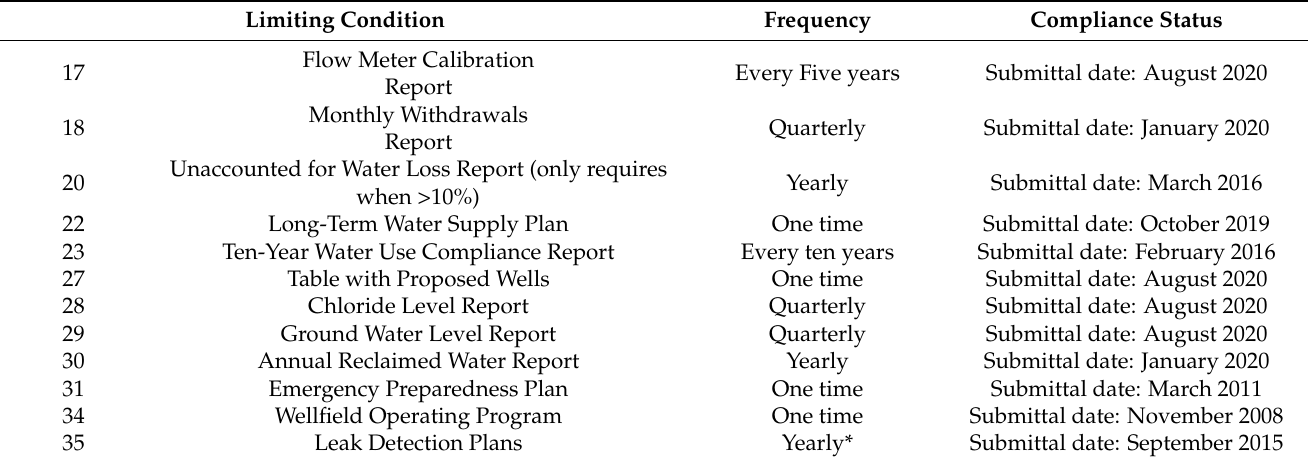
Table 2. Water Use Permit limiting conditions and